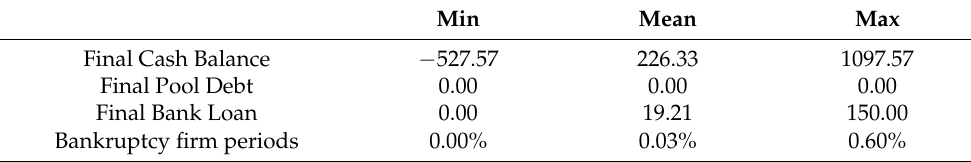
Table 17. Results for diverse operational risk, loan limits, and interest rates without